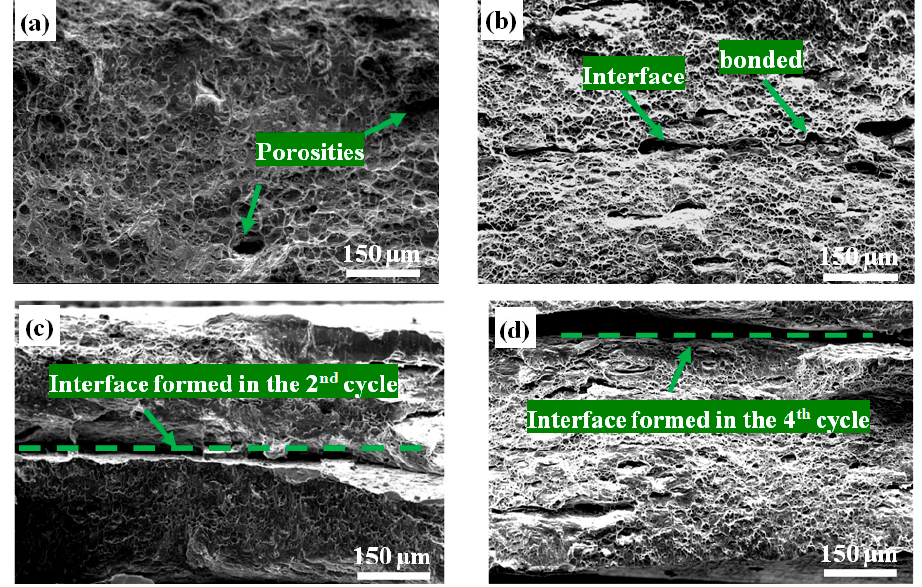
Figure 9. Tensile fracture surfaces of theAl-TiB 2 /TiC composites: ( a ) As cast; ( b – d ) After one, two and four ARB cycles, respectively.